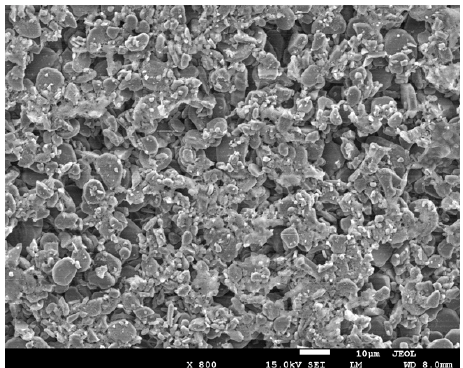
Figure 7. Microstructure of the fused alumina facecoat after fired at 850 °C in air for 2 h.